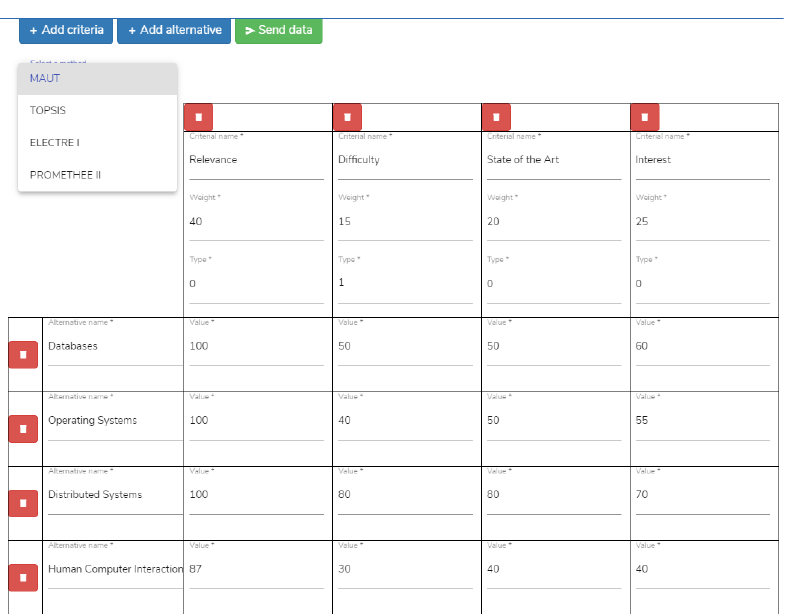
Figure 7. MAUT method results. As observed, the Databases course is considered to be easier, but it is less interesting and also less effective in providing state-of-the-art skills. Thus, the Distributed Systems course seems to be the best choice. The procedure is similar for users who want to select skills on which they should focus, and therefore, it is not presented in the context of this publication.